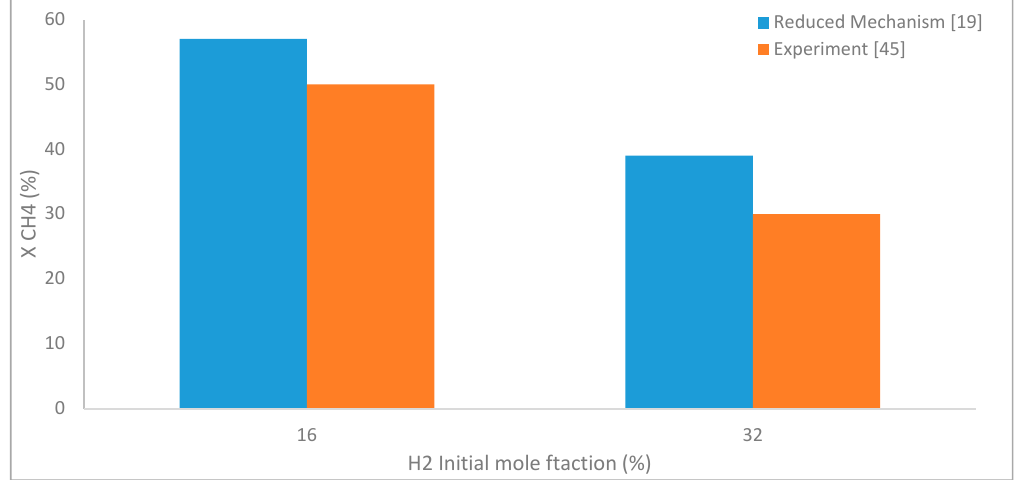
Figure 9. Comparison of the calculated CH 4 ( top ) and H 2 ( bottom ) profiles by using the reduced mechanism [19] and the experimental measurements from Reference [44] for CH 4 / H 2 50 / 50 mixture at pressure 1 bar, temperatures 950–1125 K and eq.ratios 0.1 and 0.6.